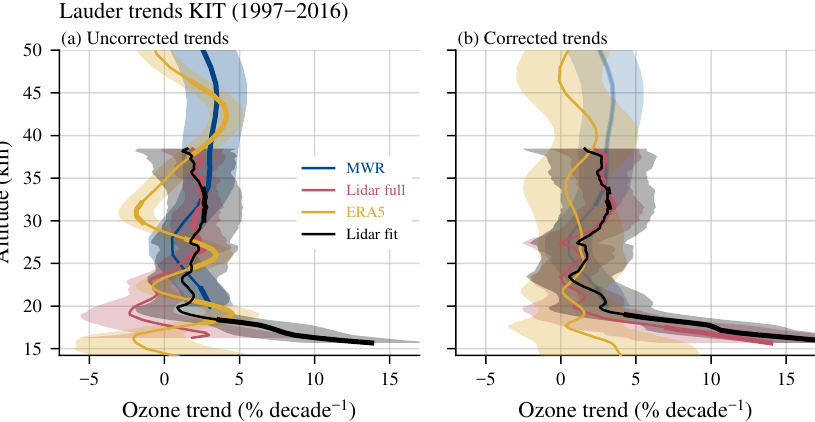
Figure 6. Ozone trends estimated with the KIT regression model for MWR, full lidar, ERA5, and sea- sonal lidar data (1997 to 2016). Trends are weighted but uncorrected with respect to biases in panel ( a ). Panel ( b ) shows weighted bias corrected trends for lidar and ERA5. Uncorrected MWR trends are also shown in ( b ) (pale color) for